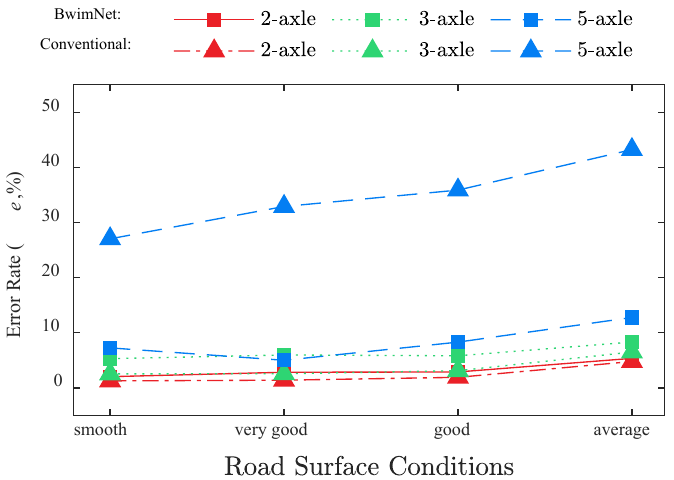
Figure 9. Axle weights identification accuracies of the proposed method and the conventional method under different RSCs.